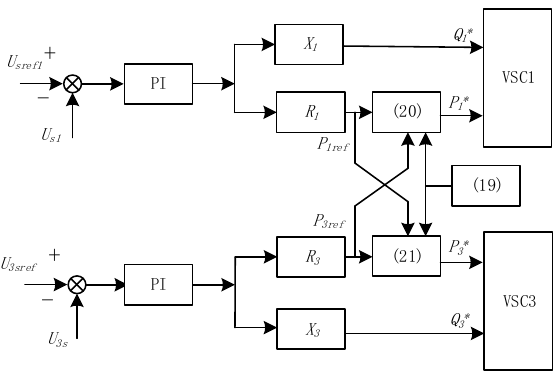
Figure 9. Local control strategy of SOP.